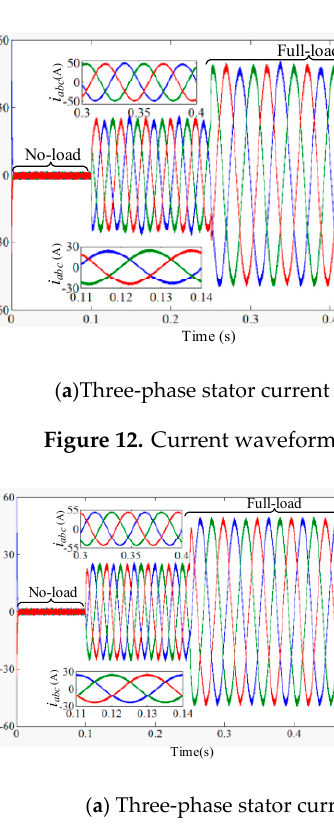
Figure 13. Current waveforms of three-phase PMSG unit 1 with PI-NRC.